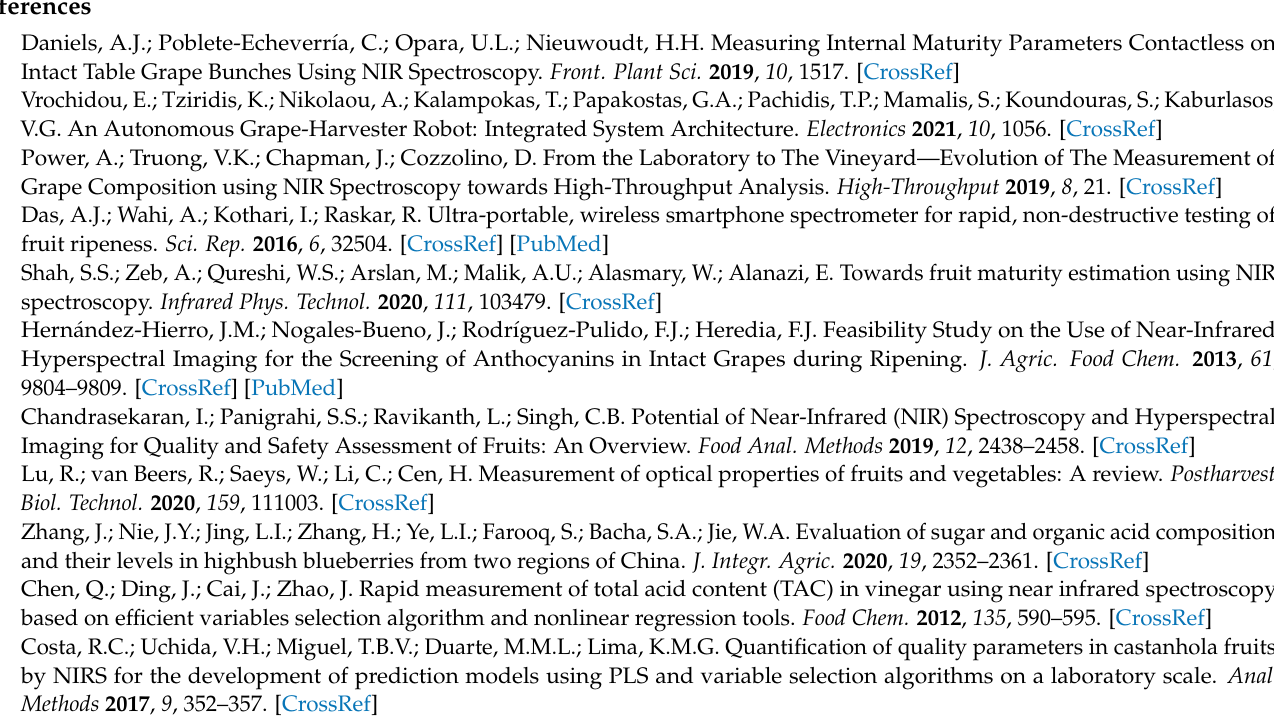
ses when the datasets from variable selection were used are given in the Supplementary Materials; Table S2: Performance of Partial Least Squares (PLS) models for TSS prediction from the entire dataset of spectra; Table S3: Performance of Partial Least Squares (PLS) models for TSS prediction from the dataset opt_Xc; Table S4: Performance of Partial Least Squares (PLS) models for TSS prediction from the dataset absxcoefs; Table S5: Performance of MLR models for TSS prediction from the entire dataset of spectra; Table S6: Performance of MLR models for TSS prediction from the opt_Xc dataset of spectra; Table S7: Performance of MLR models for TSS prediction from the absxcoefs dataset of spectra; Table S8: Selected wavenumbers (cm − 1 ) most correlated to the TSS content and in agreement with published literature on the vibration wavenumbers of sugar O-H and C-H